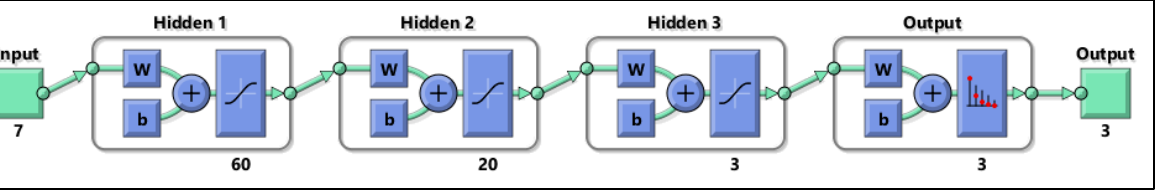
Figure 1. Schematic for neural network(s) in screening